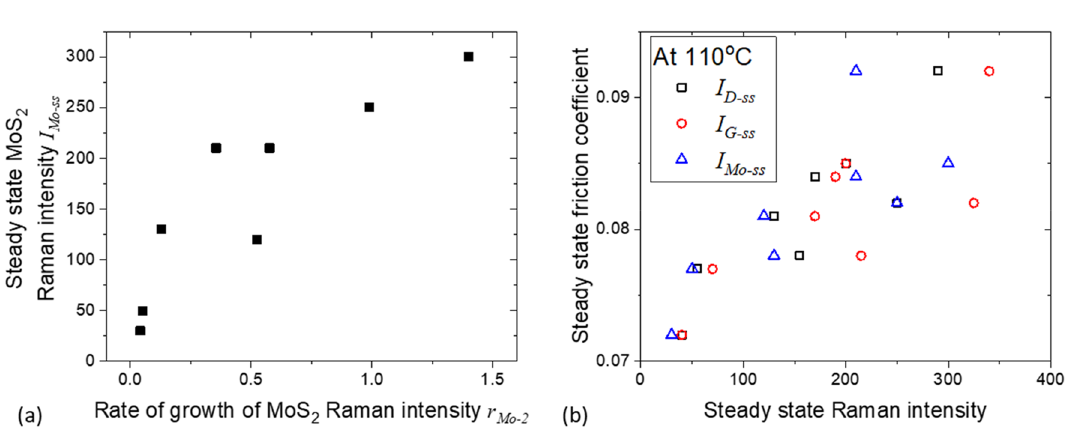
Figure 9. The effect of rate of increase of MoS 2 peak intensity on ( a ) steady state MoS 2 intensity and ( b ) steady state friction coefficient. Test temperature = 110 °C, applied load = 30–70